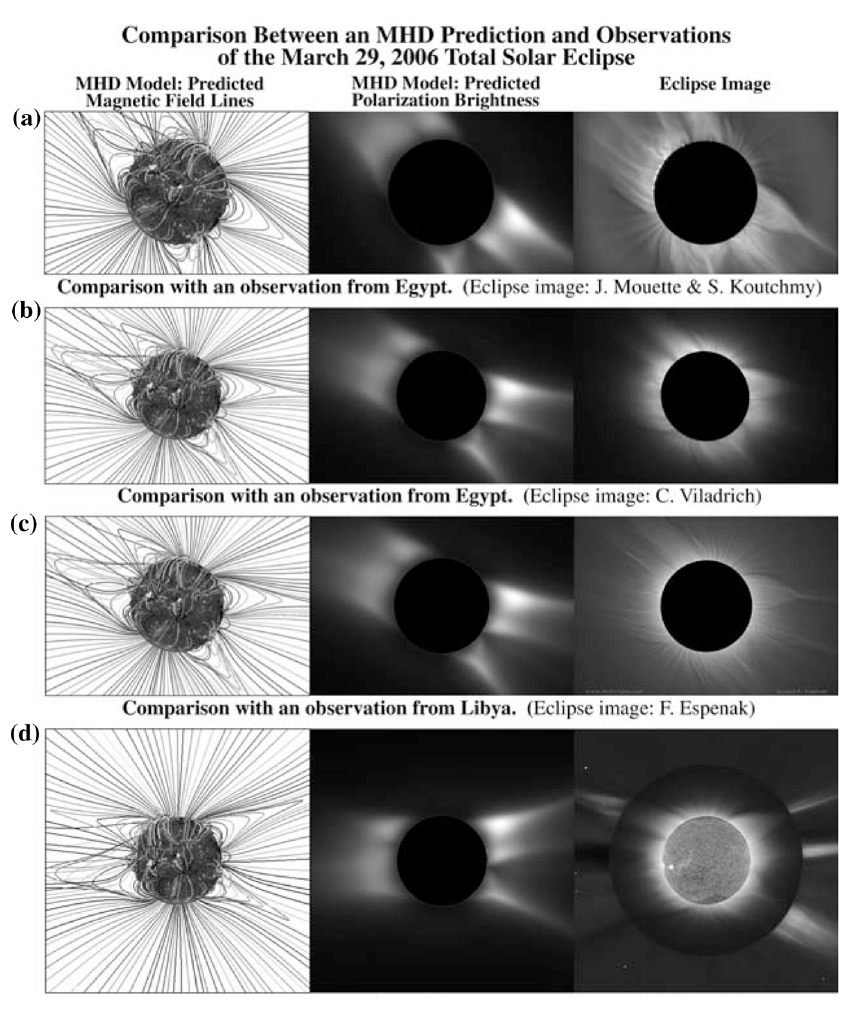
Fig. 18 Comparison between the MHD prediction (with magnetic field lines and polarization brightness shown in the first two columns) and eclipse observations (shown in the third column). Image reproduced with permission from Miki´c et al. (2007), copyright by ASP